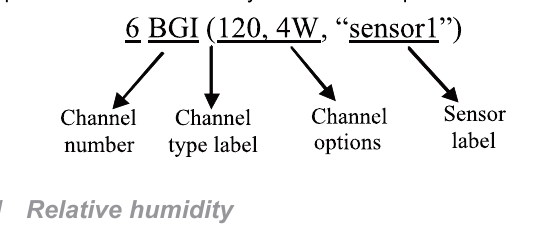
figuration. DeTransfer has specific commands to control the ac- quisition rate, the data storage in the internal memory, the internal parameter configurations of DT600, and the alarm settings. Among several sensors that DT600 accepts, this paper only pres- ents the wiring configuration of circuits designed for the sensors described in 2. The commands used for these sensors are pre- sented in Table